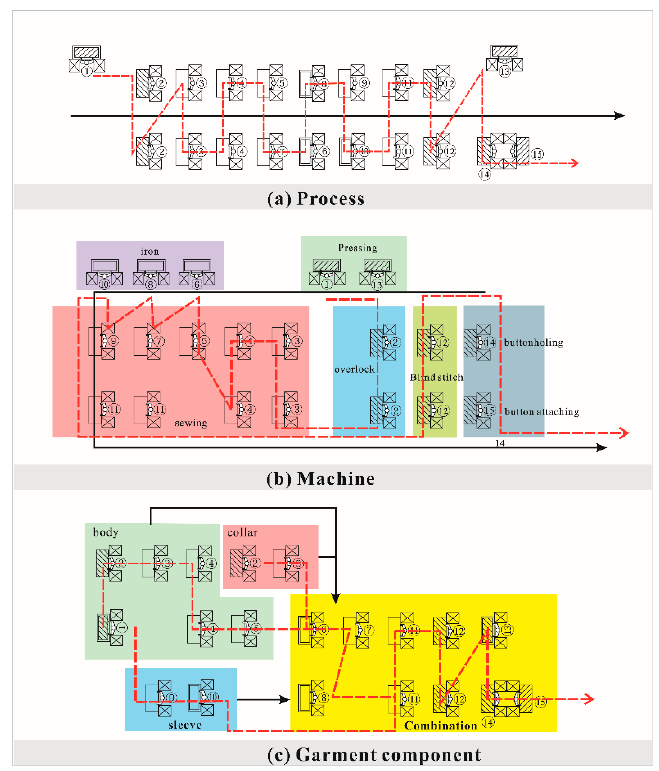
Figure 2. Schematic diagram of three workstation layouts.